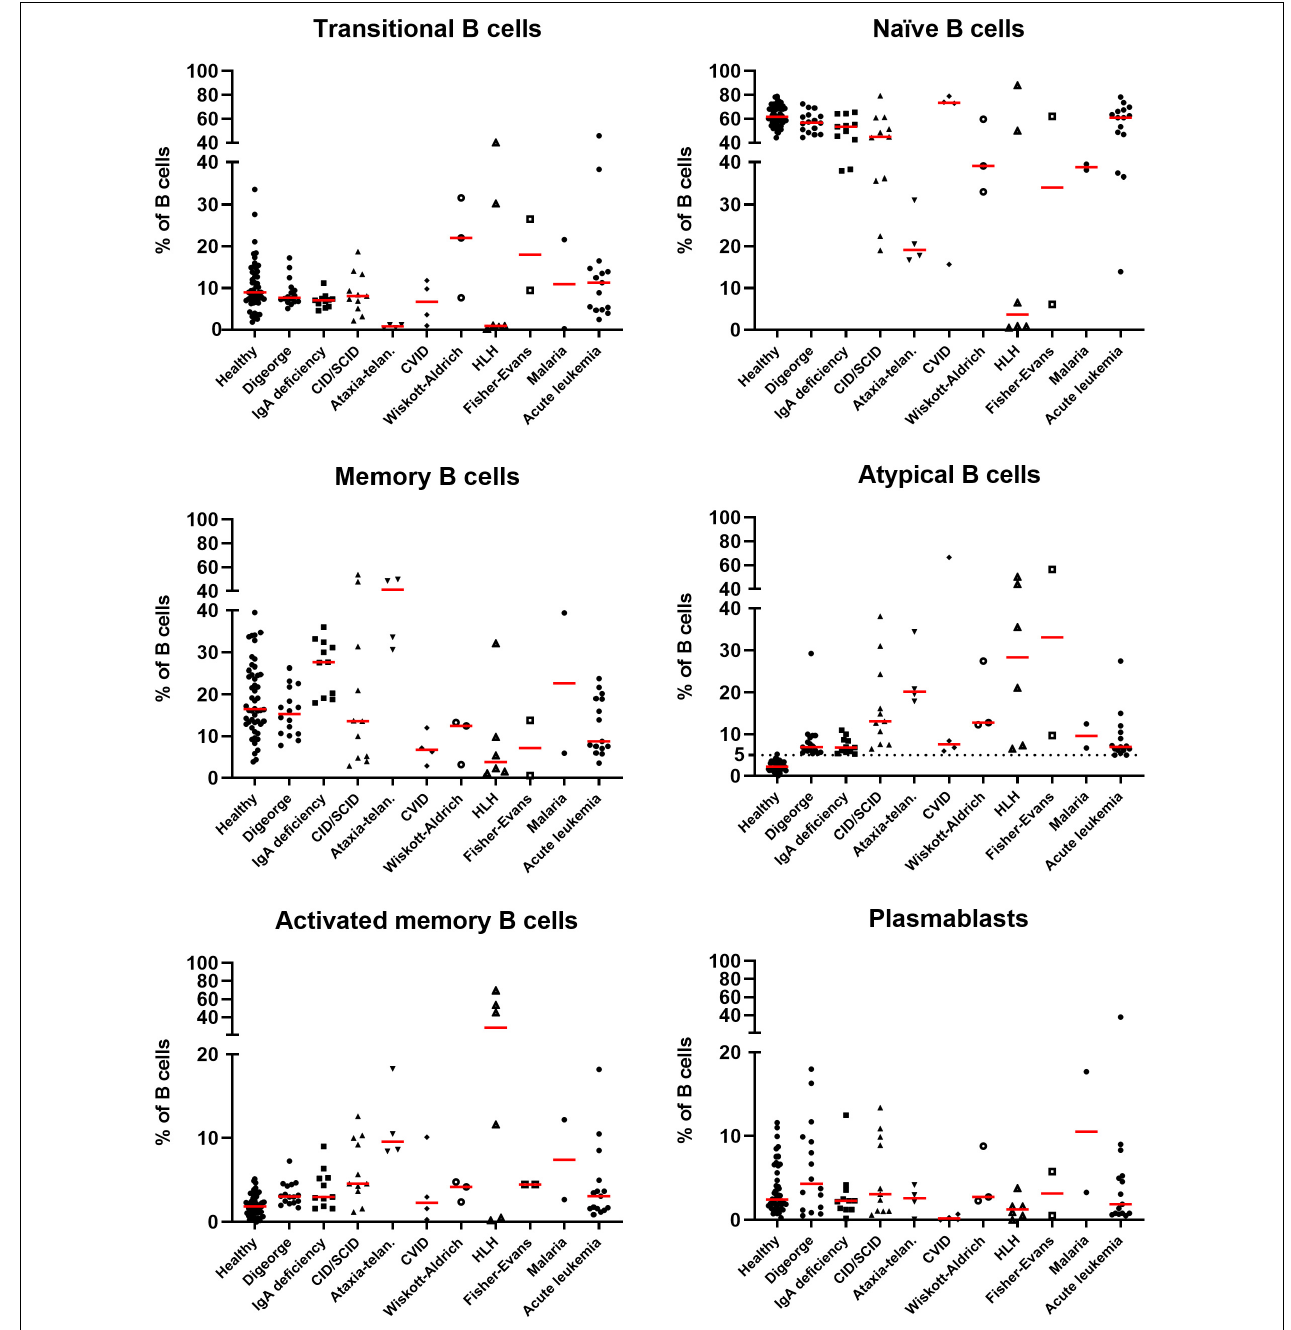
FIGURE 4 | Identification of B-cell subsets in selected pediatric disorders. Scatter dot plots indicating the percentages of B-cell subsets in selected diseases in patients with increased atBCs ( > 5%). Bars in red indicate medians.